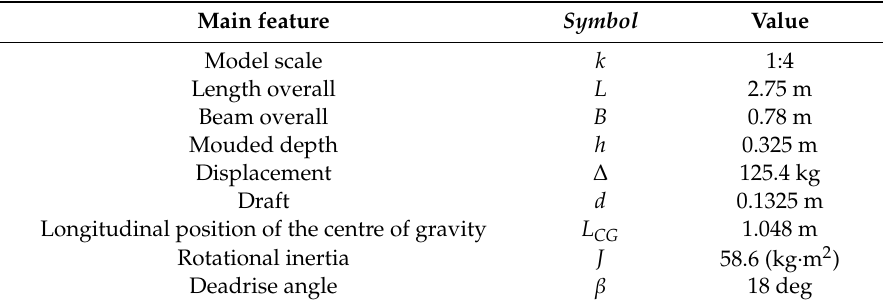
Table 1. Parameters of the model of USV01.